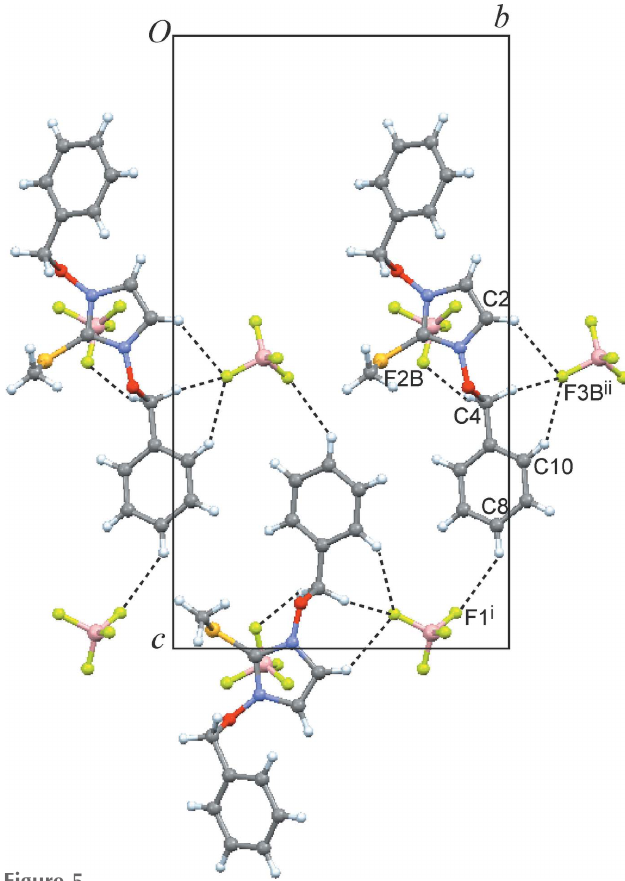
; (ii) (cid:3) x + 1, y + 1 , (cid:3) z + 2 2